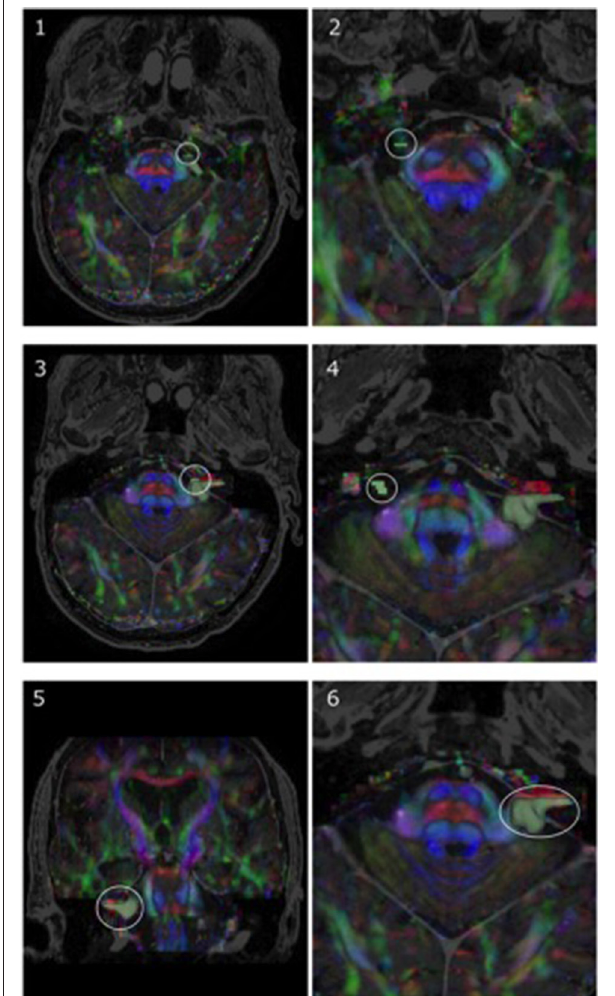
FIGURE 3 | Representative region-of-interest (ROI) seed placement, in green, in one patient with a vestibular schwannoma (P05). (1, 2) Highlight ROIs placed on anterior portions of CN V, whereas (3, 4) specify the ROI location for CN VII/VIII on both the affected side and side contralateral to the lesion, respectively. Images are displayed on a mixed anatomical-tensor model from a superior view. The mixed anatomical-diffusion tensor model represents the tensor map being overlaid on a T1 anatomical image. Pictures of the vestibular schwannoma from both a coronal perspective (5) and zoomed-in axial perspective (6) are also